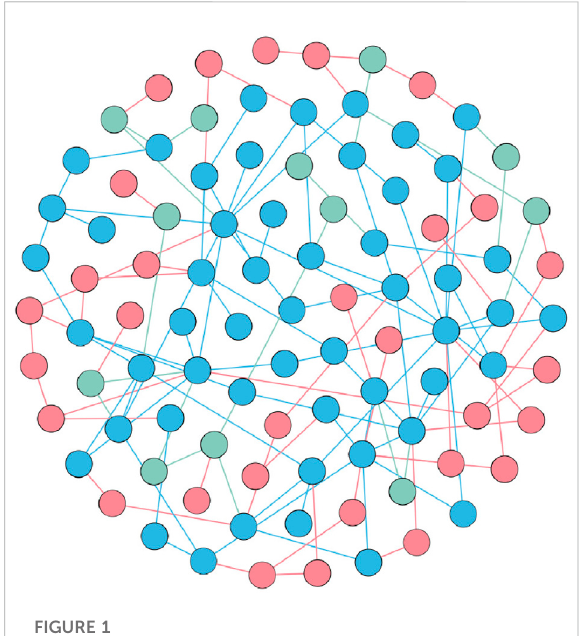
FIGURE 1 An example of a heterogeneous network. Different colors represent different types of nodes and